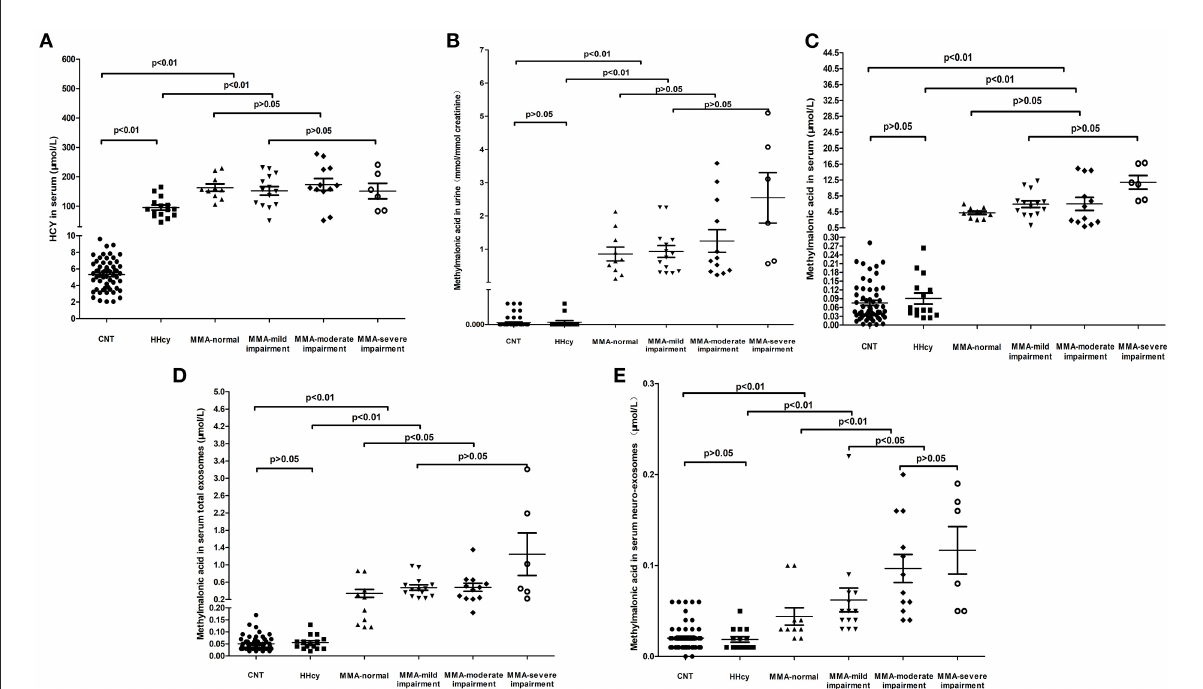
FIGURE1 The levels of HCY in serum (A) , methylmalonic acid in urine (B) , methylmalonic acid in serum (C) , methylmalonic acid in serum total exosomes (D) , and methylmalonic acid in serum neuro-exosomes (E) in different groups. HCY, homocysteine; MMA, methylmalonic acidemia; CNT, Control; HHcy, non-inherited hyperhomocysteinemia; neuro-exosomes, neuronal-derived exosomes; MMA-normal, cblC type methylmalonic acidemia patients with normal IQ or DQ; MMA-mild cognitive impairment, cblC type methylmalonic acidemia patients with mild cognitive impairment; MMA-moderate cognitive impairment, cblC type methylmalonic acidemia patients with moderate cognitive impairment; MMA-severe cognitive impairment, cblC type methylmalonic acidemia patients with severe cognitive